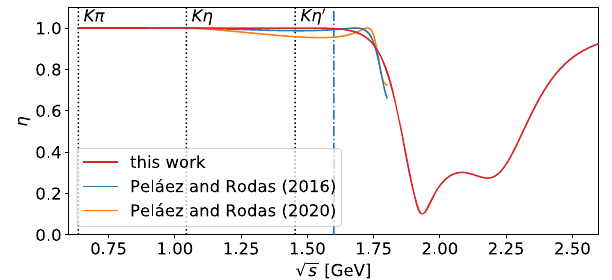
Fig. 3 Elasticities η of the π K isospin- 1 wave extracted from Peláez 2 and Rodas (2016) [64], Peláez and Rodas (2020) [7], and our model. The dashed blue line denotes the end of the range of validity of the analysis from Ref. [64] at 1 .